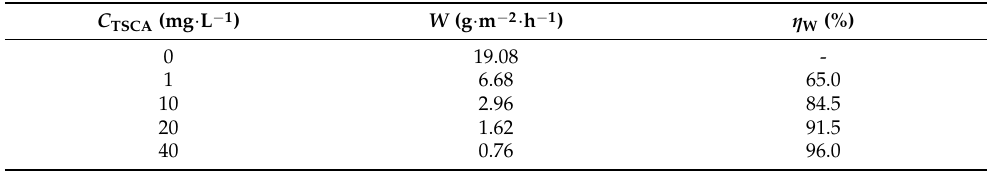
Table 1. Corrosion rate of carbon steel and inhibition efficiency of TSCA at various concentrations for carbon steel in 1 M HCl at 298